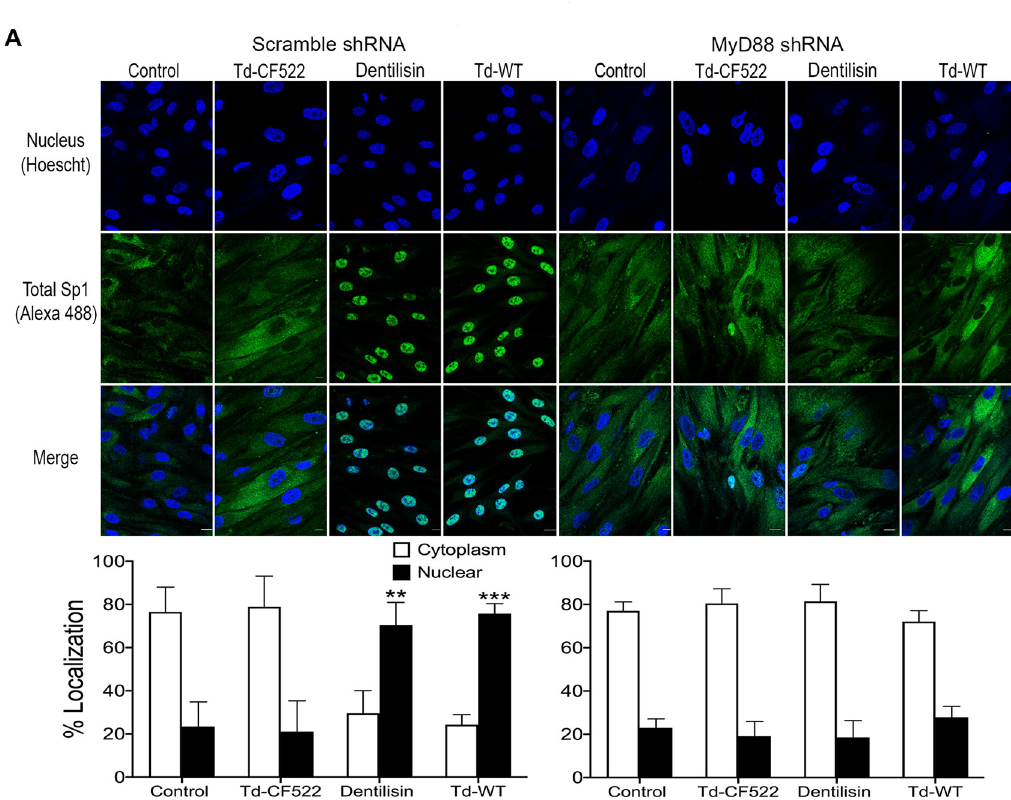
Fig 8. Knockdown of MyD88-dependent signaling inhibits translocation of transcription factor Sp1 in both T . denticola - and dentilisin-stimulated hPDL cells. A) Scrambled shRNA control and MyD88 shRNA hPDL cells were challenged or stimulated with Td-CF522, purified dentilisin or Td-WT at an MOI of 50 and concentration of 1 μ g/mL for 2-hours in alpha- MEM media with no supplementation followed by a 22-hour incubation in alpha-MEM media supplemented with 10% FBS, 1% Pen/Strep and 1% Amphotericin B. Cells were stained with Hoescht 33342 (Blue) and total Sp1-specific antibodies (Green) and subjected to confocal microscopy. Scale bar represents 10 μ m. Scale bar represents 10 μ m.